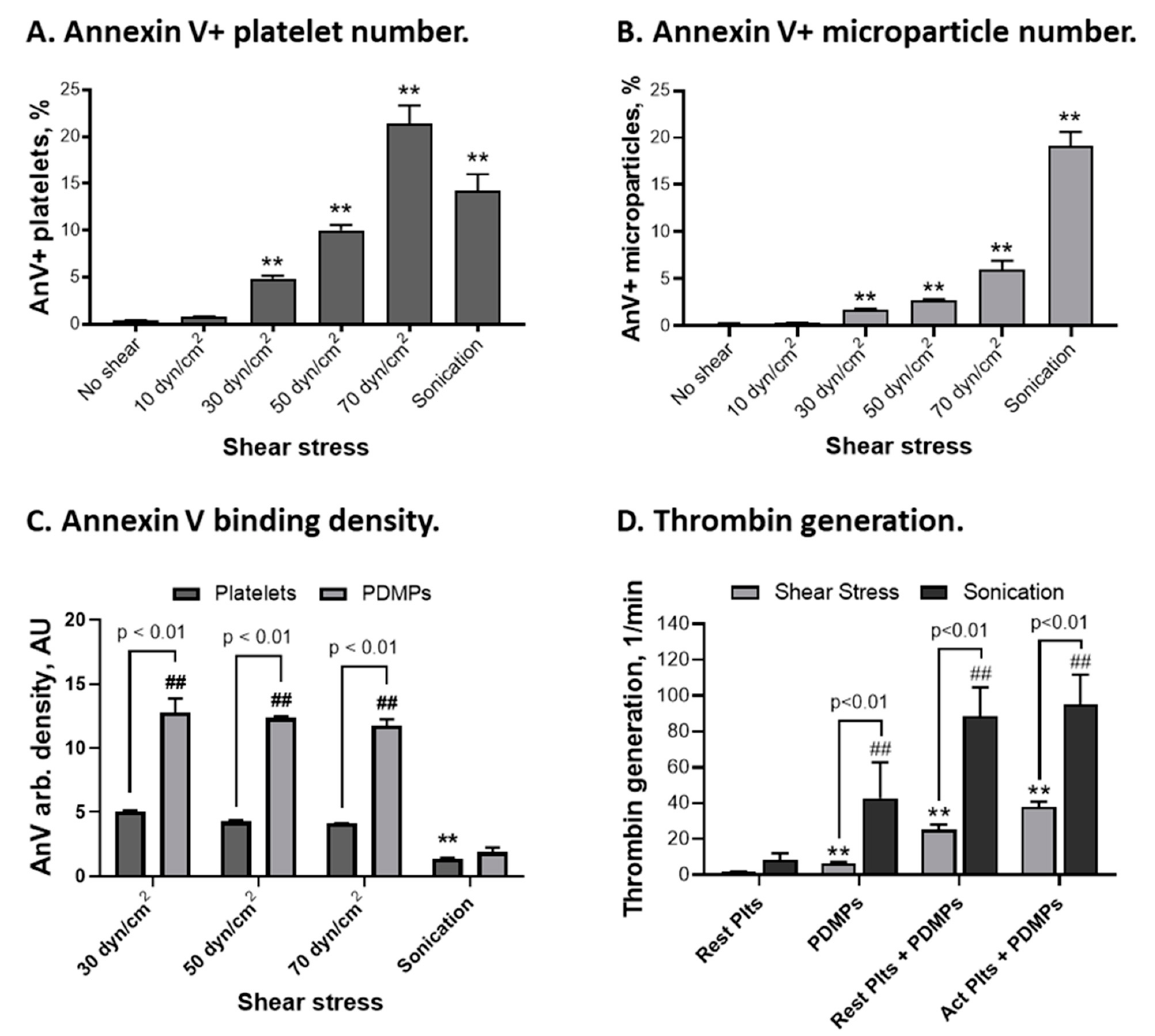
Figure 8. Platelets and platelet-derived microparticles (PDMPs) expose anionic phospholipids on their surface and promote thrombin generation exposure to shear stress and sonication: ( A , B )—the number of platelets and PDMPs binding annexin V (AnV+/CD41+ particles), ( C )—arbitrary density of annexin V binding on platelets and PDMPs. ( D )—thrombin generation on platelets and microparticles generated via shear stress exposure (70 dyne/cm 2 , 30 min) or sonication: “Act Plts + PDMPs”— platelets and microparticles following shear exposure or sonication. n = 5–7. Mean ± SEM, 1-way ANOVA followed by Dunnett multiple comparisons test: **, ##— p < 0.01 vs. no shear for platelets and PDMPs.